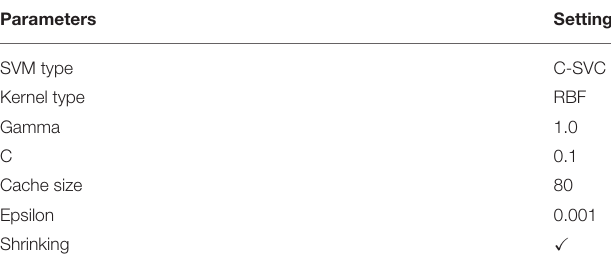
TABLE 3 | The parameters setting of the LIBSVM method. Parameters